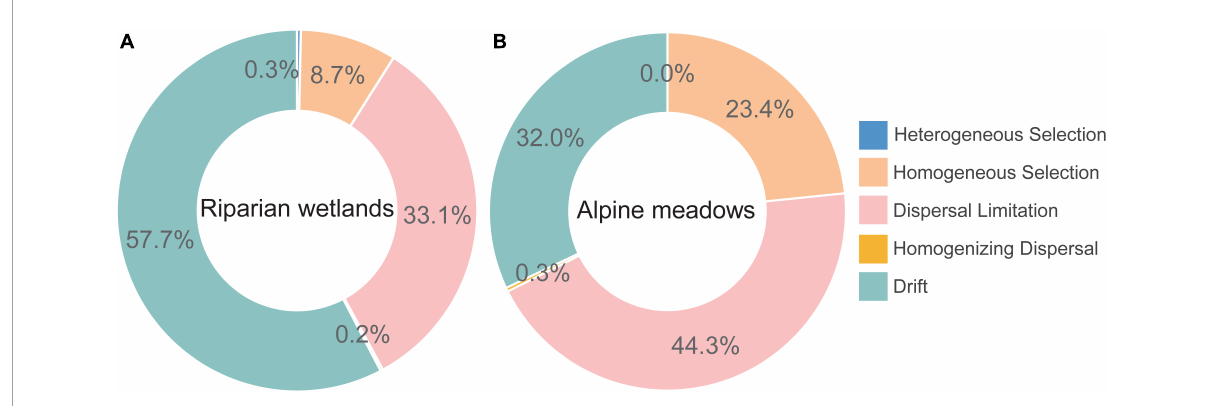
FIGURE3 The assembly mechanisms of soil diazotrophic communities in the (A) riparian wetlands and (B) alpine meadows.